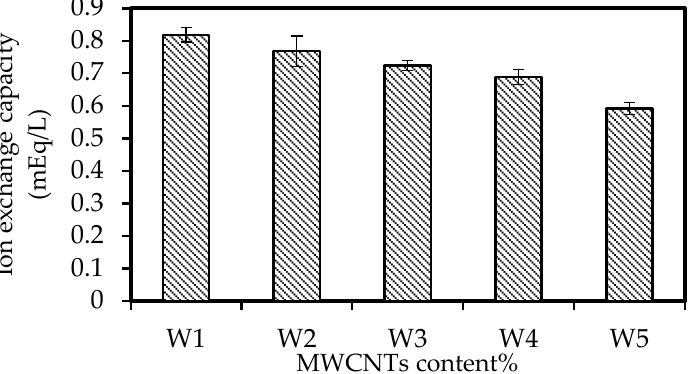
Figure 6. The IEC of the W1, W2, W3, W4, and W5 samples.